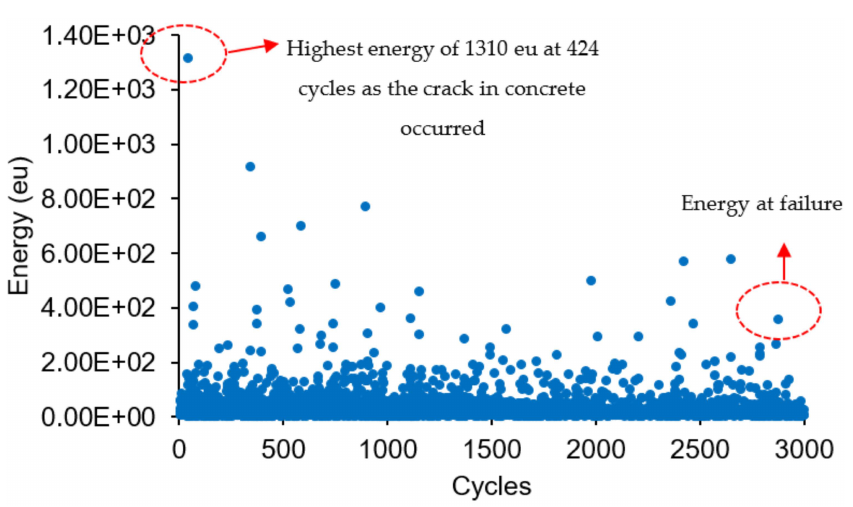
Figure 15. Energy distribution along the cyclic